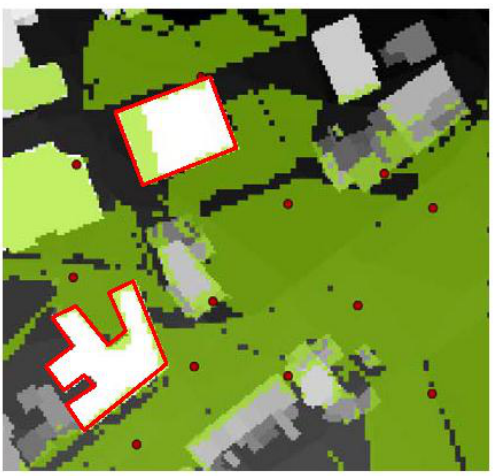
Figure 16. Coverage map of deploying 12 sensors using the context-aware method, considering the buildings (Zone 2) as the restricted area (the red border